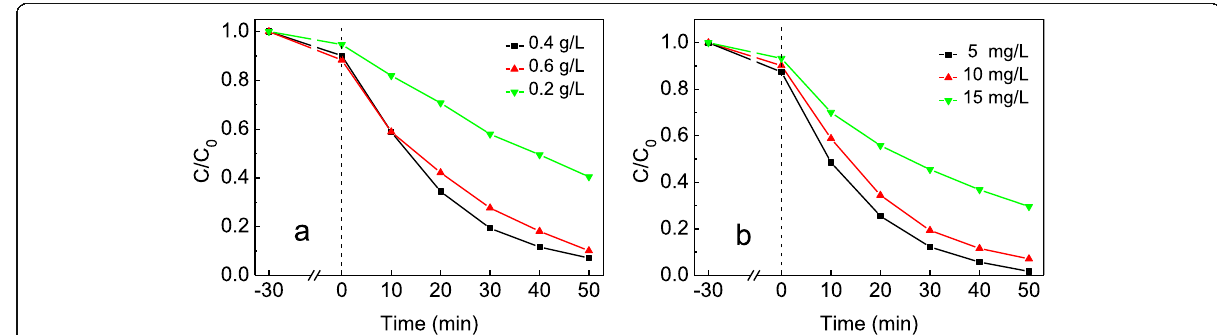
Fig. 6 a Effect of different Ag 3 PO 4 /T-ZnOw-2 doses on the photodegradation of RhB. b Effect of different initial concentrations of RhB on the photocatalytic activity of